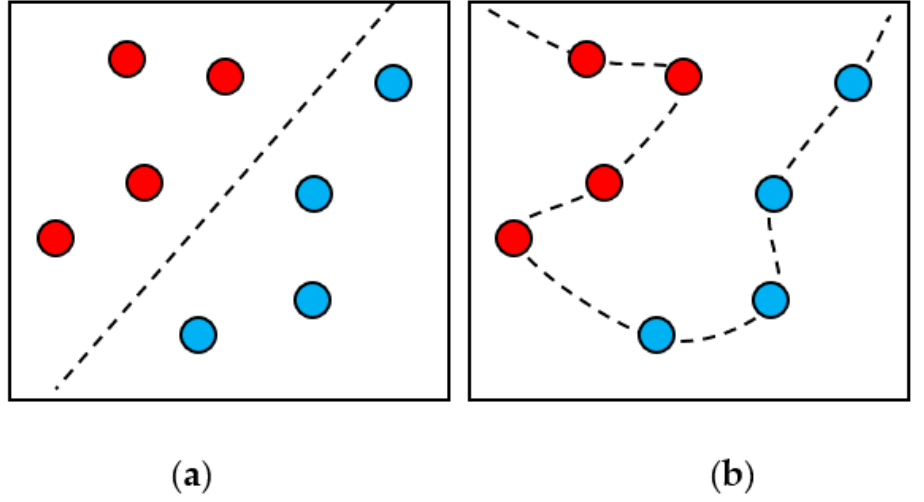
Figure 10. The conceptual difference between SVM and SVR; ( a ) the dividing line is far away from the data point; ( b ) the dividing line is close to the data point.